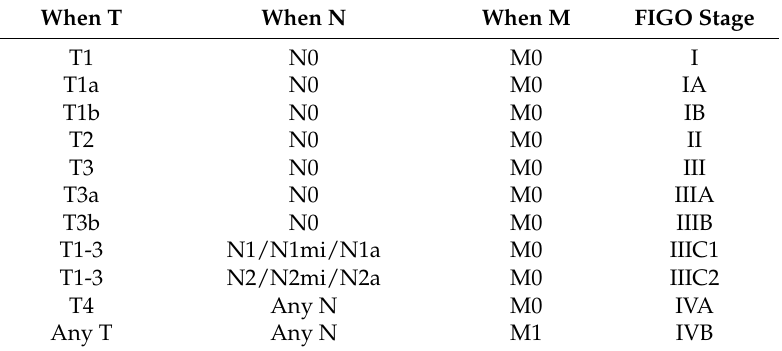
Table 1. TNM and International Federation of Gynecology and Obstetrics (FIGO) staging scoring system of endometrial cancer. When T When N When M FIGO